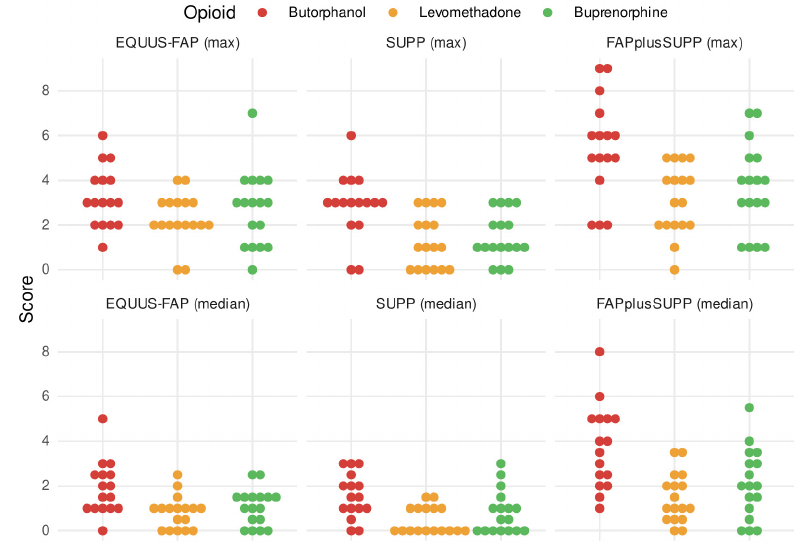
Figure 2. Median and maximum pain scores. Comparison of the total score awarded (maximum = upper row and median = lower row) of the respective pain scores. (From left to right: EQUUS-FAP, SUPP, FAPplusSUPP.) Representation with dot plot.